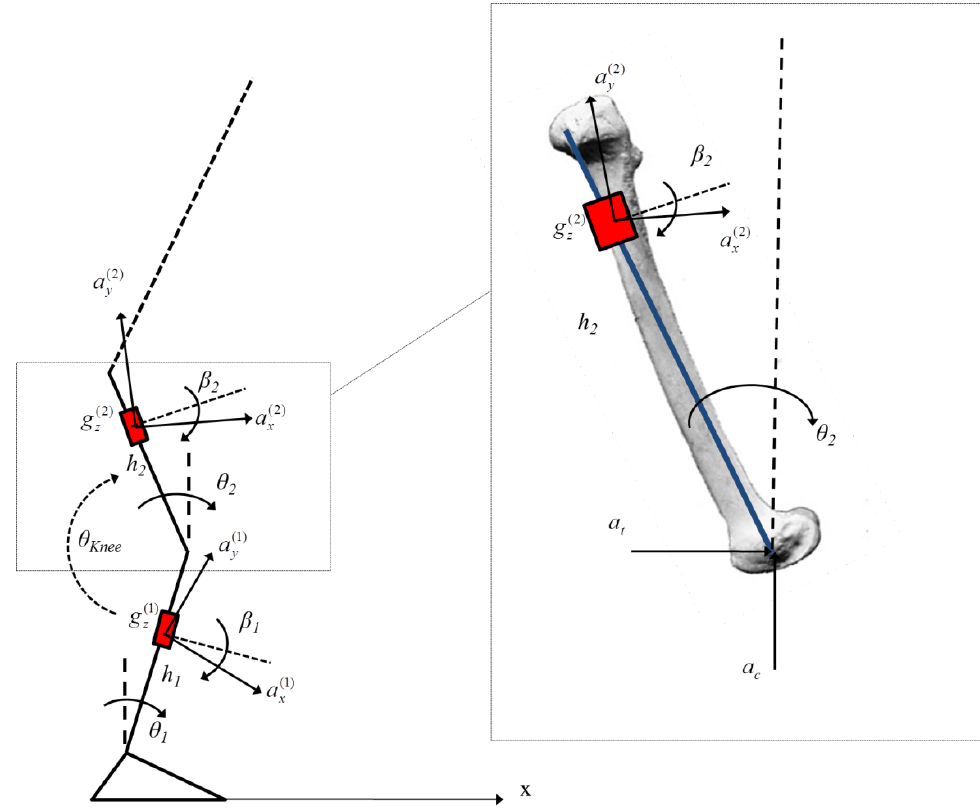
Figure 4. Two-links model for the knee flexion-extension angle